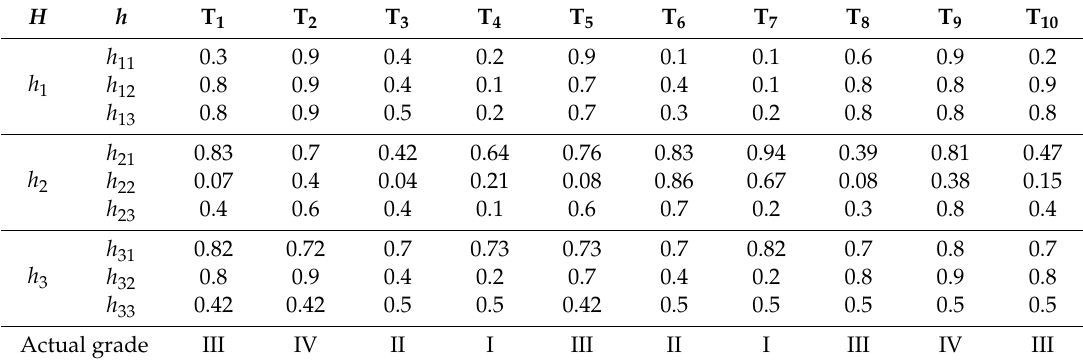
Table 6. Stability grades for slopes in group A.